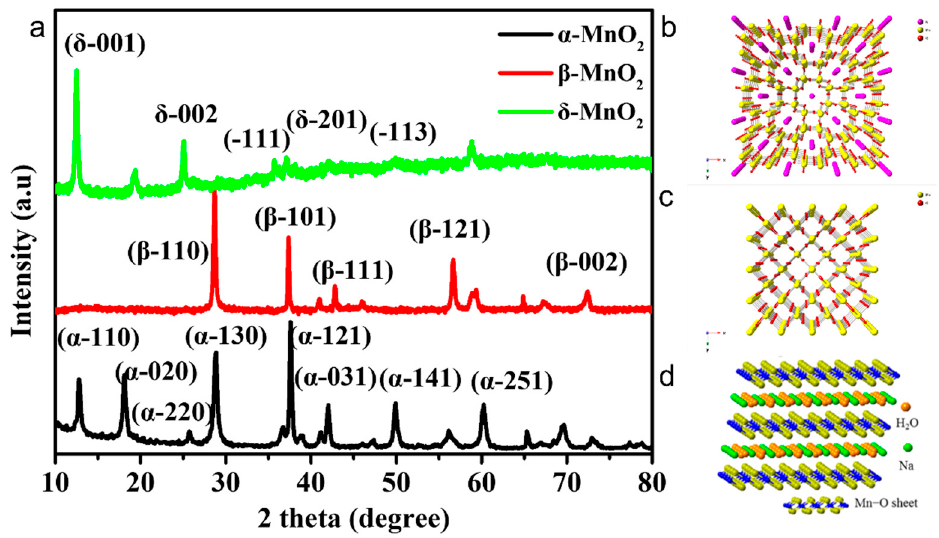
Figure 1. ( a ) X-ray powder diffraction of α -MnO 2 , β -MnO 2 , and δ -MnO 2 . Ball and stick models for the theoretical structures of ( b ) α -MnO 2 and ( c ) β -MnO 2 phase. Yellow and red spheres are Mn and O atoms, respectively, while the pink spheres are K ions in the tunnel ( b ) (The theoretical model was obtained by CrystalMaker 10.8). ( d ) Structural illustration of the as-prepared Na ion and water molecule intercalated layered δ -MnO 2 . Copyright © 2019, American Chemical Society.